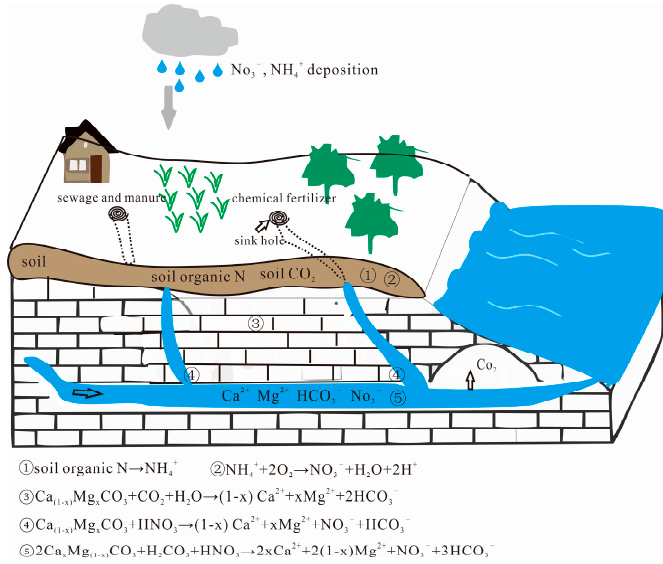
Figure 6. The C-N coupling cycle in the karst zone (adapted from Hu et al., 2017 [58]).